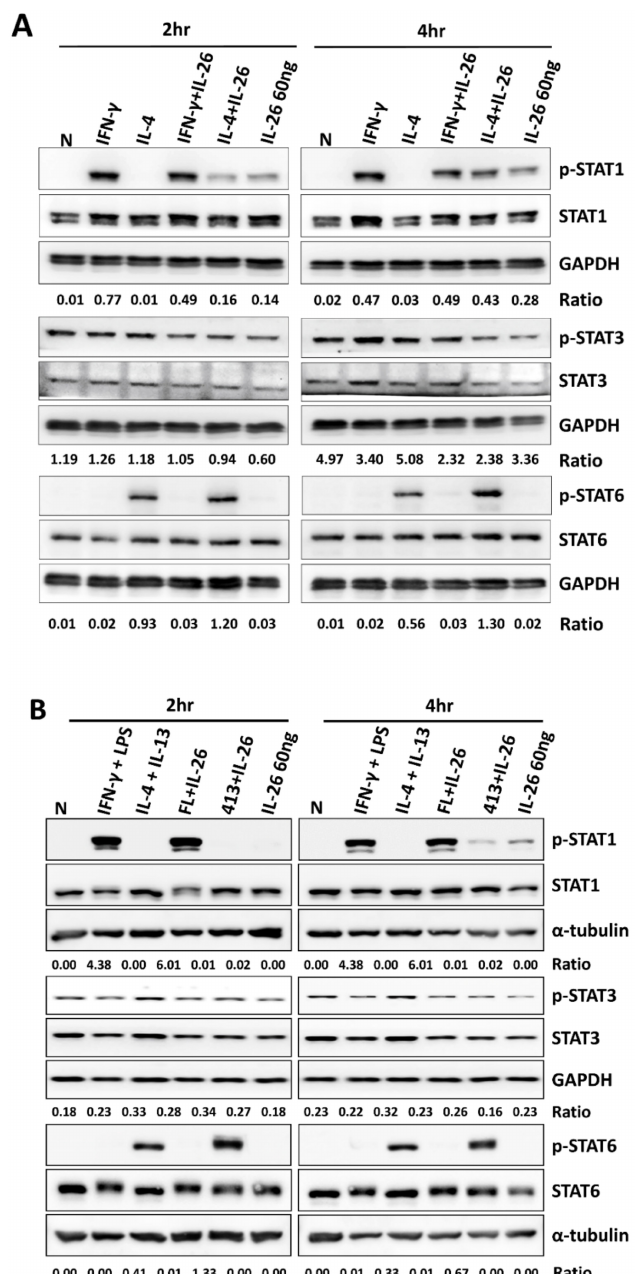
Figure 4. E ff ect of IL-26 on STAT1, STAT3, and STAT6 activation in M1 and M2 macrophage di ff erentiation. ( A ) RAW264.7 cells were serum-starved for 16 h and treated with IFN- γ (20 ng / mL) or IL-4 (20 ng / mL) in the presence or absence of IL-26, and ( B ) THP-1 cells were treated with IFN- γ (20 ng / mL) plus LPS (10 ng / mL) or IL-4 (20 ng / mL) plus IL-13 (20 ng / mL) in the presence or absence of IL-26 for 2 and 4 h to further detect phosphorylated or non-phosphorylated STAT1, STAT3, and STAT6 proteins. Cell extracts were analyzed by western blot using antibodies specifically directed against the phosphorylated forms of STATs, compared with data obtained with antibodies directed against the unphosphorylated states of the kinases. Equal amounts of protein were loaded in each lane as demonstrated by the level of GAPDH. A representative result of at least three independent experiments is shown. (FL + IL-26: IFN- γ + LPS + IL-26; 413 + IL-26: IL-4 + IL-13 +